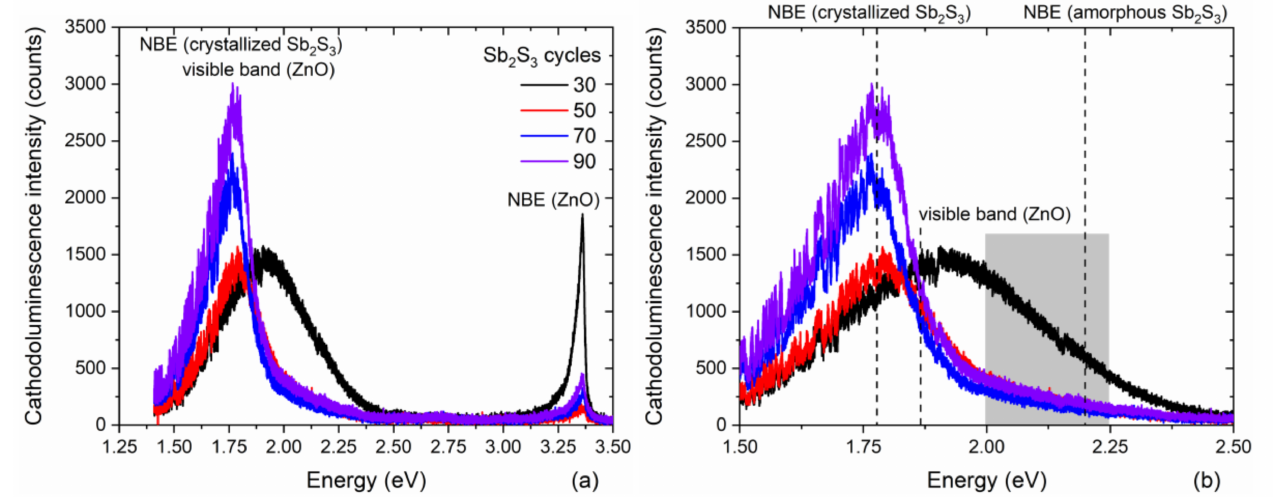
Figure 4. ( a ) 5 K cathodoluminescence spectra collected on an ensemble of single ZnO/TiO 2 core– shell NW heterostructures covered with a Sb 2 S 3 shell grown by CSP using 30, 50, 70, and 90 cycles. A fixed surface area of 3 × 3 µ m 2 was chosen for the acquisition. ( b ) Zoom-in in the area of interest corresponding to the visible energy range from 1.5 to 2.5